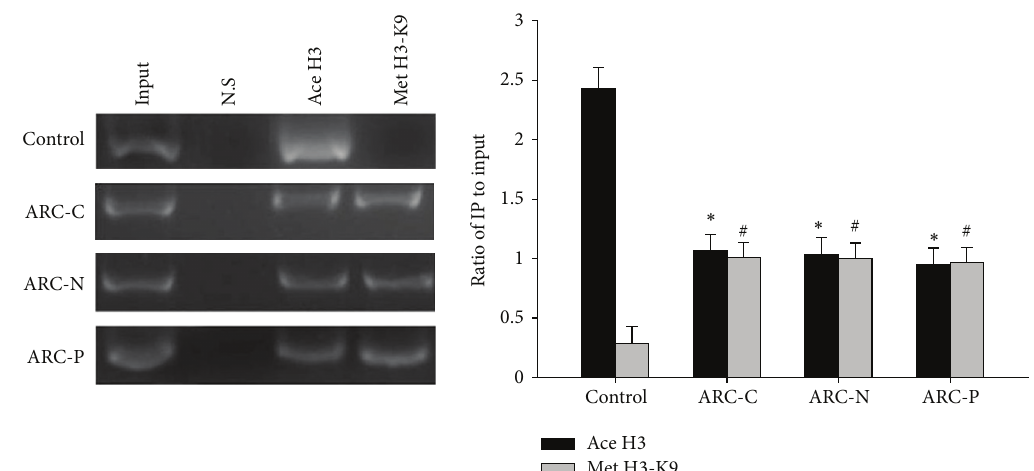
Figure 3: Histone modifications of the WRN promoter in anterior lens capsules of control and ARC. In anterior lens capsules, compared with the control group ( 𝑛 = 10 ), ChIP analysis revealed that acetylated H3 levels were lower in ARC-C ( 𝑛 = 10 ), ARC-N ( 𝑛 = 10 ), and ARC-P ( 𝑛 = 10 ). At the same time, methylated H3-K9 was increased. ∗ 𝑃 < 0.01 .